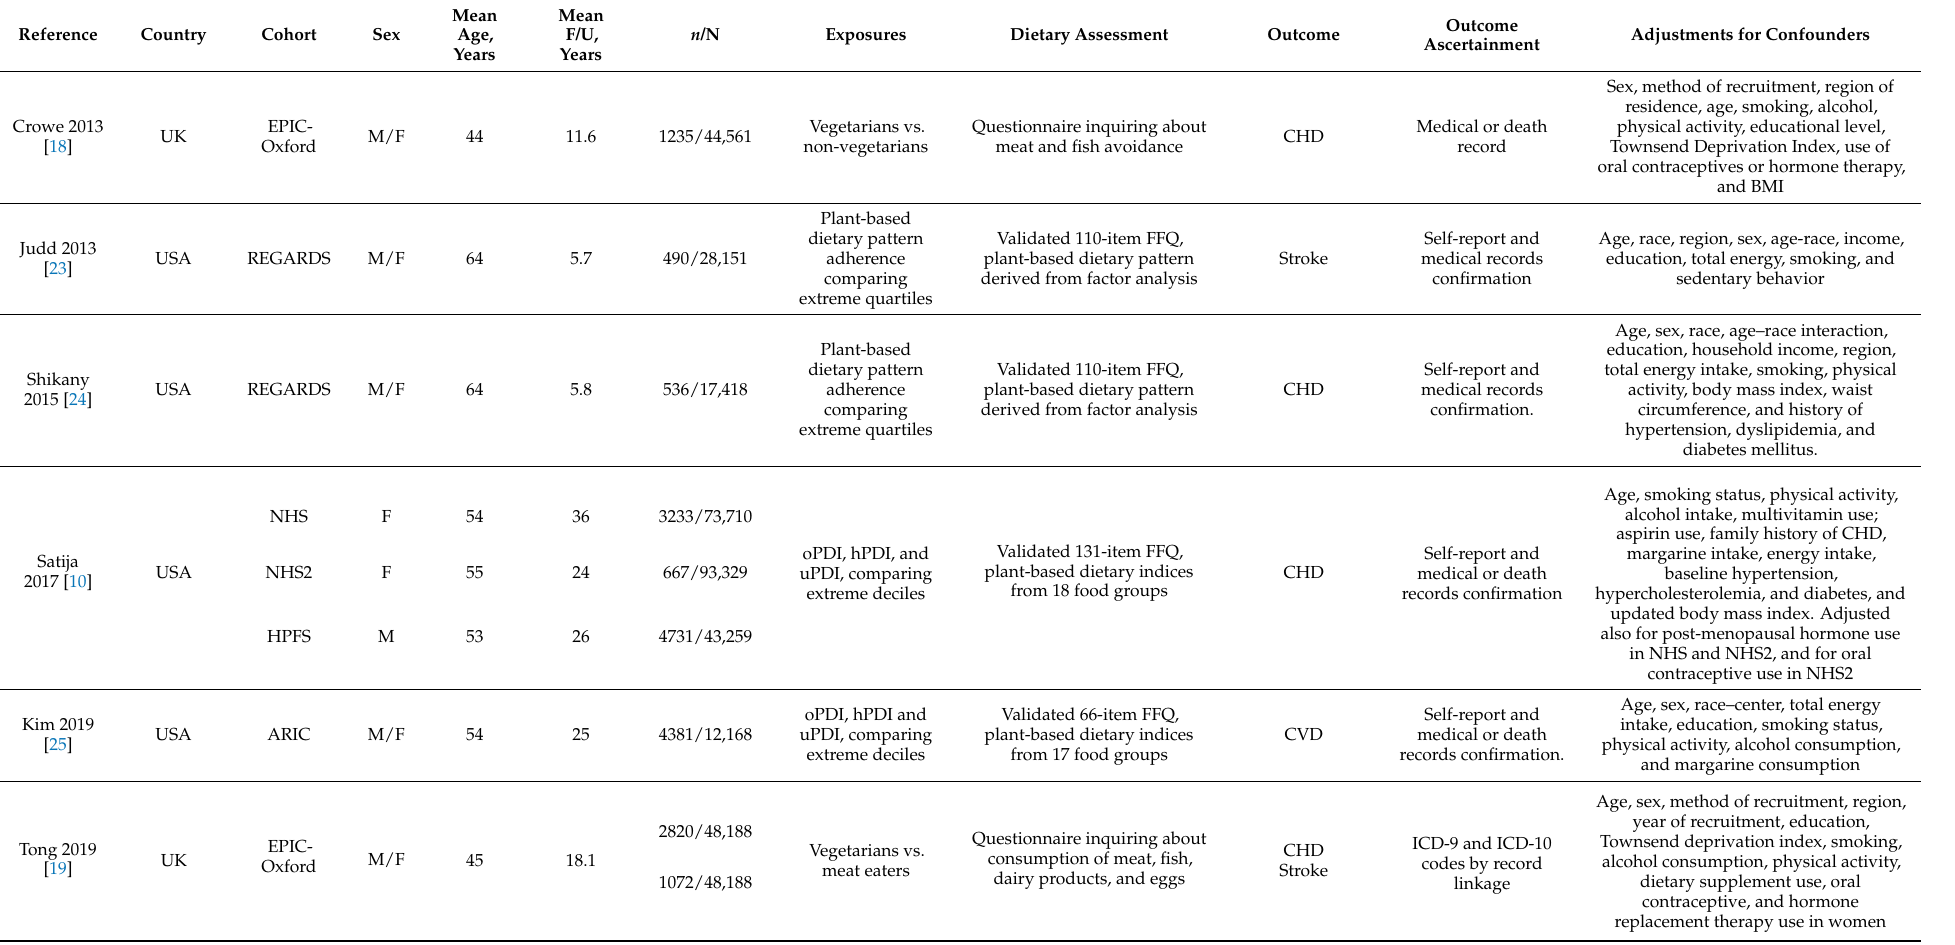
Table 1. The baseline characteristics of the included studies on plant-based diet and the incidence of cardiovascular